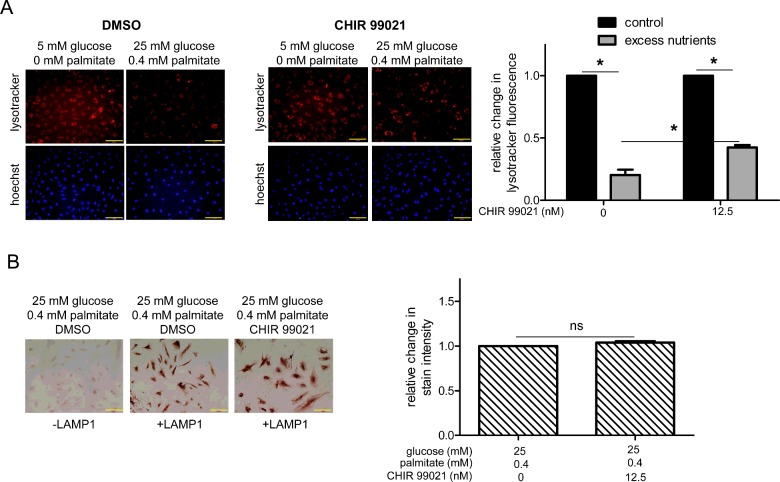
Reduction of GSK3β activity with CHIR 99021 attenuates the effects of excess nutrients on lysosome acidification(A) Compared with excess nutrient-exposed HAECs treated with vehicle alone (DMSO), those incubated with 12.5 nM CHIR 99021 for 23 h had more lysotracker staining. Representative images are shown adjacent to graph. * indicates P<0.05 by Student's t test (n=3). (B) CHIR 99021 treatment did not affect LAMP1 staining in cells incubated in excess nutrient conditions. ns indicates no significant difference (n=3). Quantification of fluorescence or LAMP1 is relative to the number of cells in each image. Bar=100 μm.